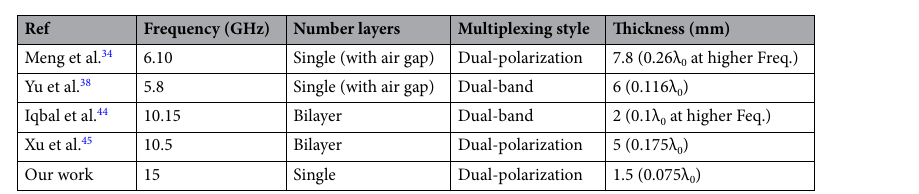
Table 1. Comparison of the proposed metasurface with referenced